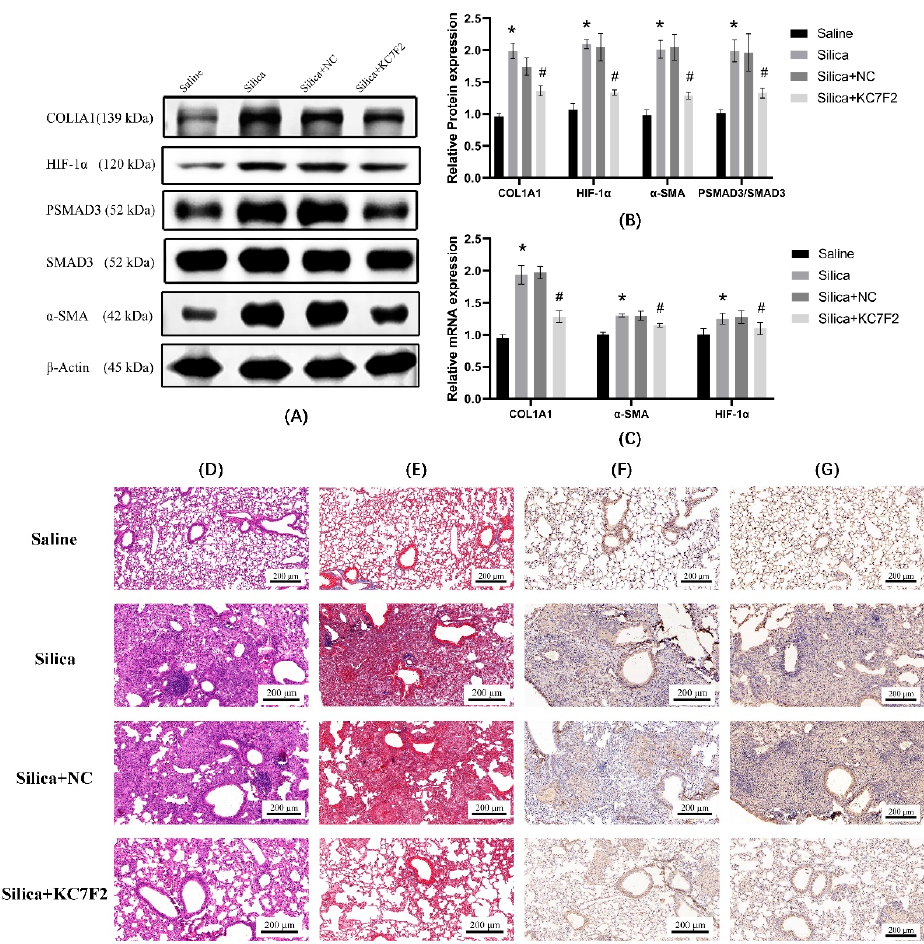
Figure 7. A mouse PF model was established by nonexposure tracheal drip in C57BL/6N mice using saline or silica. The extent of PF in mice was inferred by Western blot, PCR, and IHC. Saline group (saline tracheal drip), silica group (silica particles tracheal drip), silica + NC group (silica particles tracheal drip, using saline intraperitoneal injection), and silica + KC7F2 group (silica particles, using KFC7F intraperitoneal injection). ( A ) Western blot analysis of COL1A1, HIF-1 α , α -SMA, SMAD3, and PSMAD3 in lung tissue of different groups. β -actin was used as loading control. ( B ) Quantitative analysis of COL1A1, HIF-1 α , α -SMA PSMAD3/SMAD3 is shown in Figure 7A. ( C ) Quantitative analysis of the expression of mRNA. β -actin was used as an internal control. ( D ) H & E trichrome staining of mice lung tissue ( E ) Masson trichrome staining of mice lung tissue ( F ) IHC of COL1A1 protein. ( G ) IHC of HIF-1 α protein. * p < 0.01 vs. saline group; # p < 0.01 vs. silica group. Results are expressed as means ± SD. ANOVA was used to compare multiple groups and pairwise comparisons were compared by LSD-t test. A value of p < 0.05 was considered to be statistically significant.